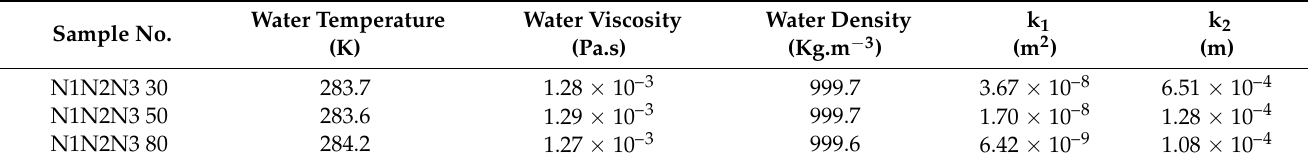
Table 3. The measured and empirically obtained water properties, as well as the empirically ob- tained permeability coefficients, i.e., the Darcy k 1 and non-Darcy k 2 .